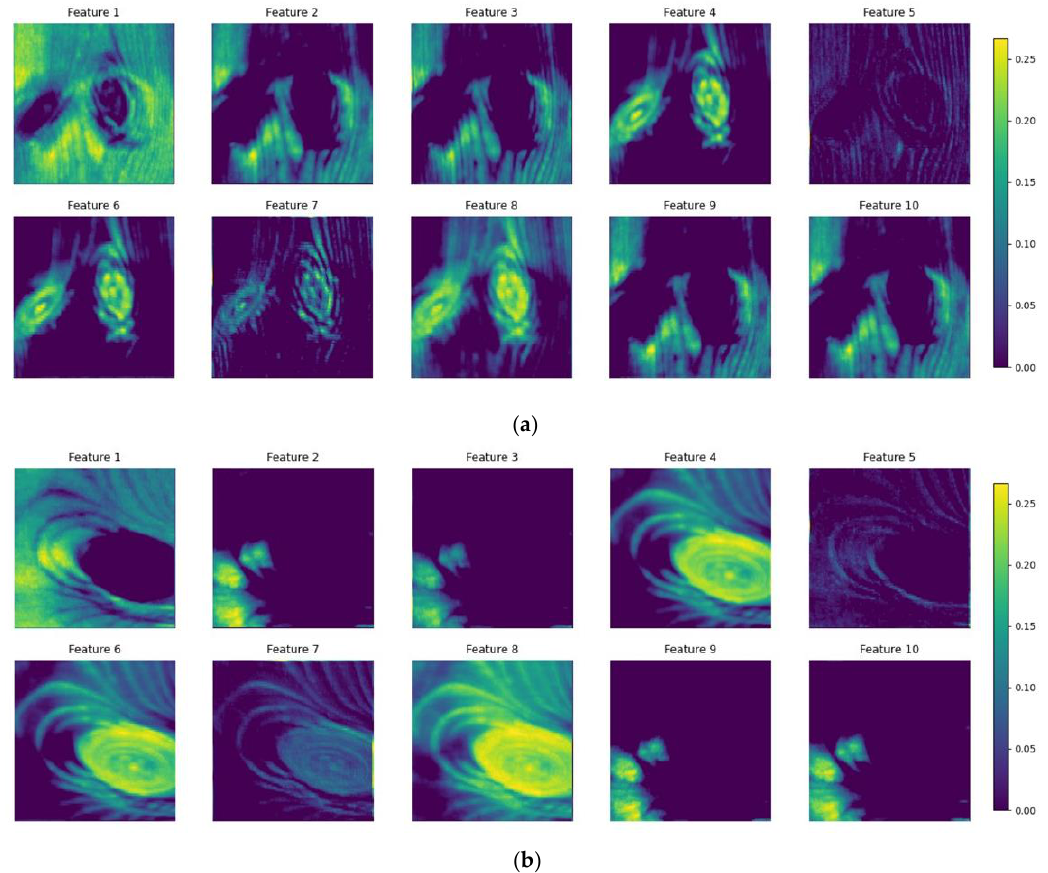
Figure 11. Visualization of the output features of two defect pictures extracted by different convolution kernels. ( a ) Features of an image with two live knots, ( b ) Features of an image with one live knot.